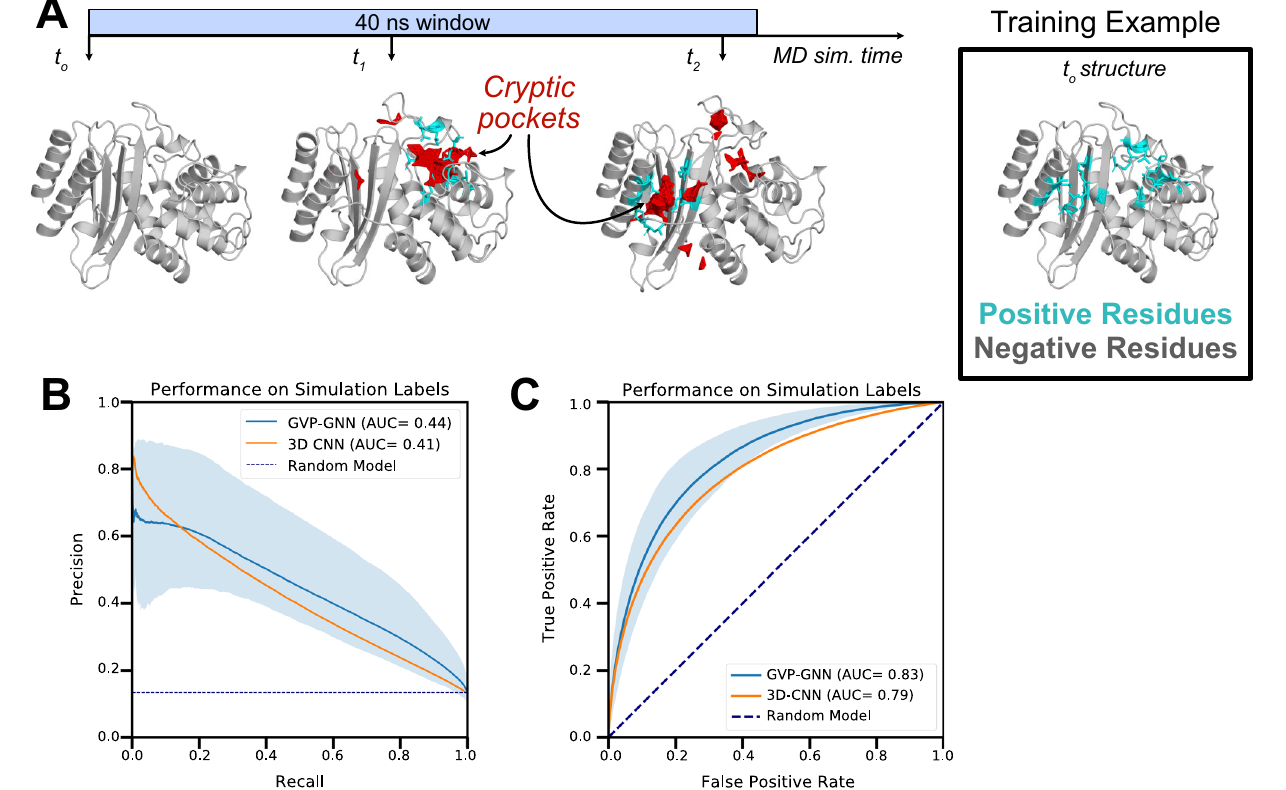
Fig.3|Graphneuralnetworksaccuratelyforecastthesitesofpocketformation in new simulations. A We used MD simulations to generate training labels by tracking where cryptic pockets (shown in red) form. Residues were labeled as positive examples if a cryptic pocket formed nearby that residue at any point in simulation (shown in cyan). As an illustration, we show the TEM β -lactamase pro- tein,whichformscrypticpocketsattwoseparatesites(i.e.,thehornpocketandthe omega loop pocket) in a single MD simulation. Each opening event marks the nearby residues as positive examples, so the training labels for this window re fl ect both opening events with residues around both pockets marked as positive examples. The starting structure can then be fed to a graph neural network that predictswherecrypticpocketswillform. B Precision-recallcurvesacross5different